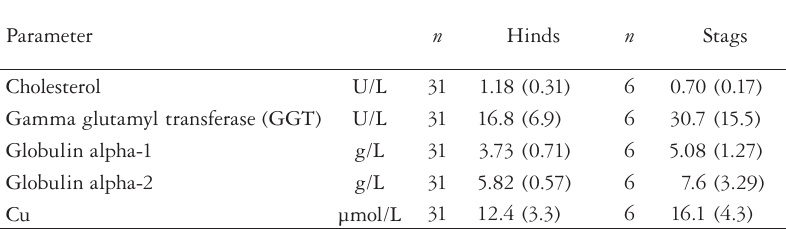
Table 5. Differences in serum biochemical parameters between hinds and stags ( P < 0.01). Mean values are shown with standard